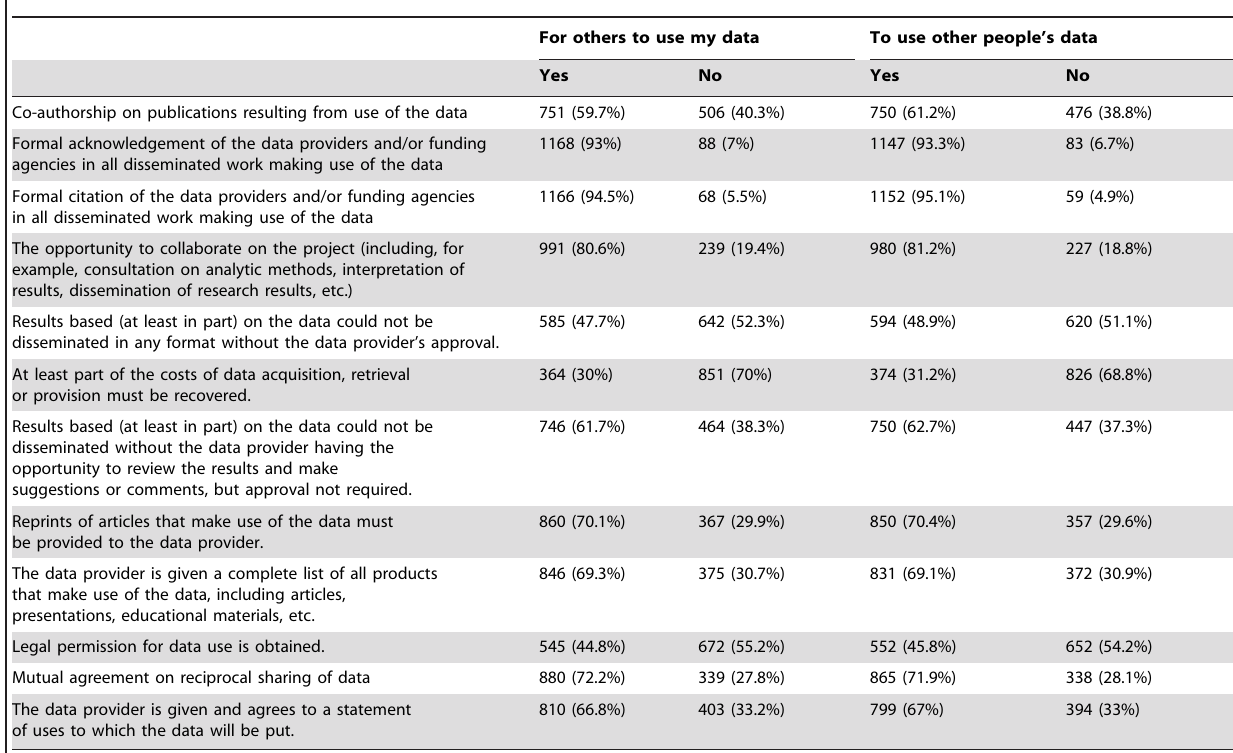
Table 14. Others using data & using others’